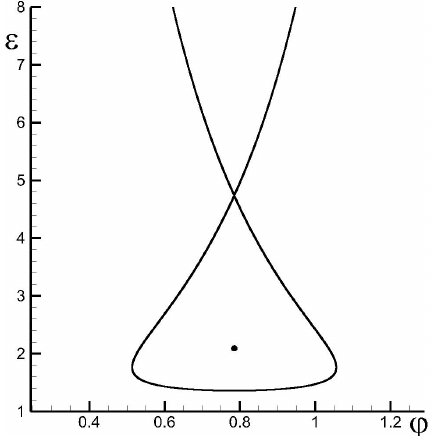
Figure 1. The phase portrait of the stationary system (1) in the case of one elliptic and one hyperbolic critical point for e 0 = 0 . 15, γ 0 = 0 .